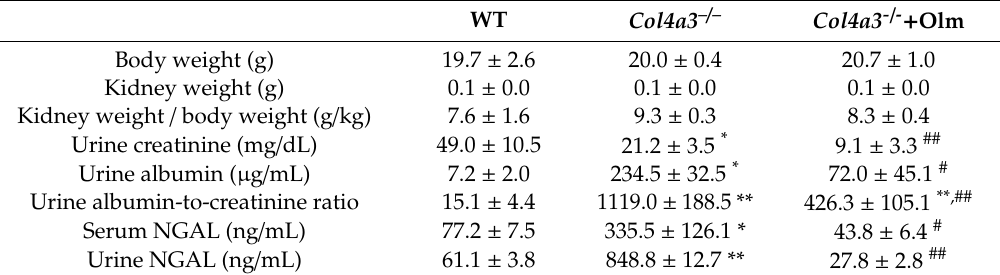
Table 1. E ff ect of Olmesartan on the renal function in Col4a3 – / – mice. WT Col4a3 – / – Col4a3 - / - + Olm Body weight (g) 19.7 ± 2.6 20.0 ± 0.4 20.7 ±